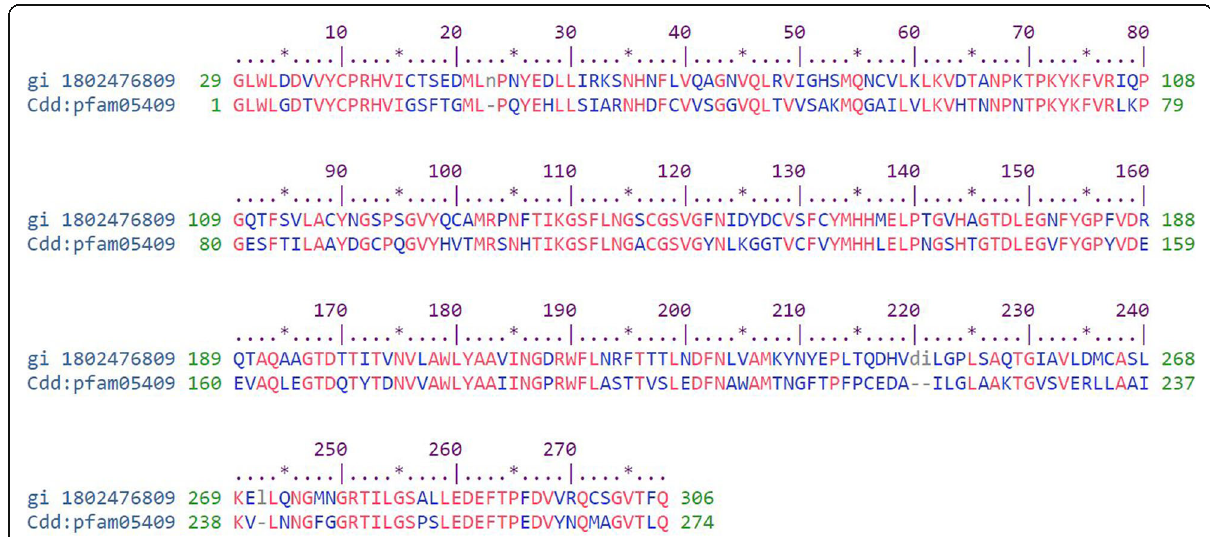
Fig. 4 Conserved domain alignment output. The coronavirus endopeptidase C30 which corresponds to the Merops family C30. These peptidases are involved in viral polyprotein processing in replication and are conserved in the protein